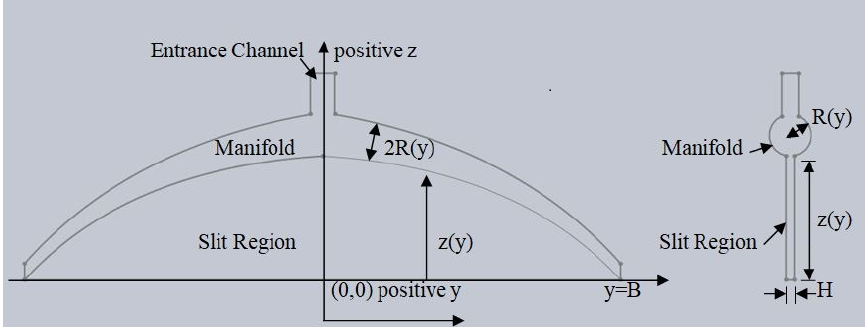
Figure 1. Front view, central